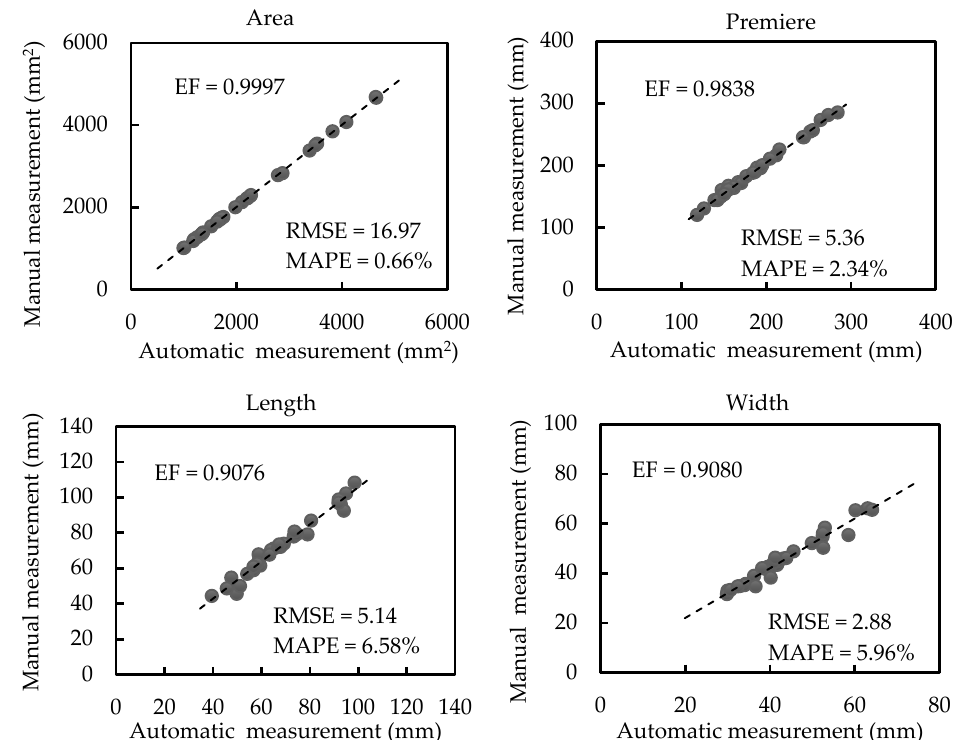
Figure 8. Regression analyses between automatic and manual measurements of scale-related traits of plants with a little occlusion (plants in group 2).